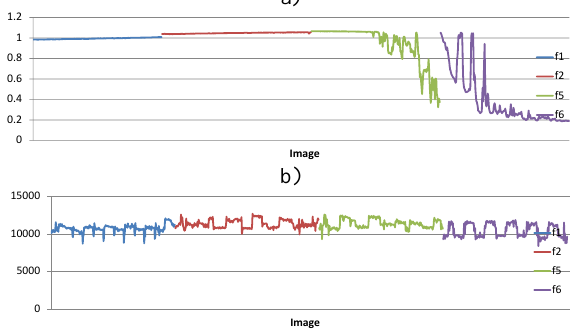
Figure 8. Irradiance measured for each image a) on ground level by ASD at 794 nm and b) in the UAV by the Intersil wideband irradiance sensor.